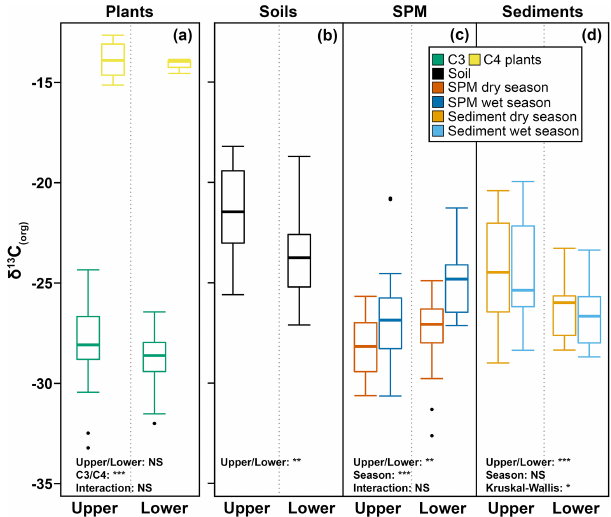
MAP (1901–2015) was markedly lower in the upper than the lower Godavari basin ( p ≤ 0 . 001), and this contrast